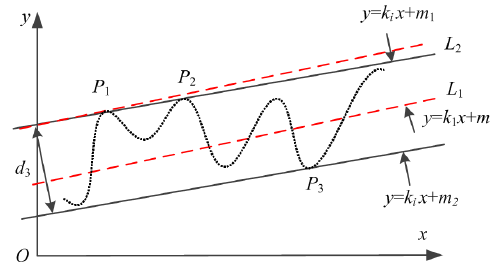
Figure 6. Graphical demonstration of enveloped line search algorithm.